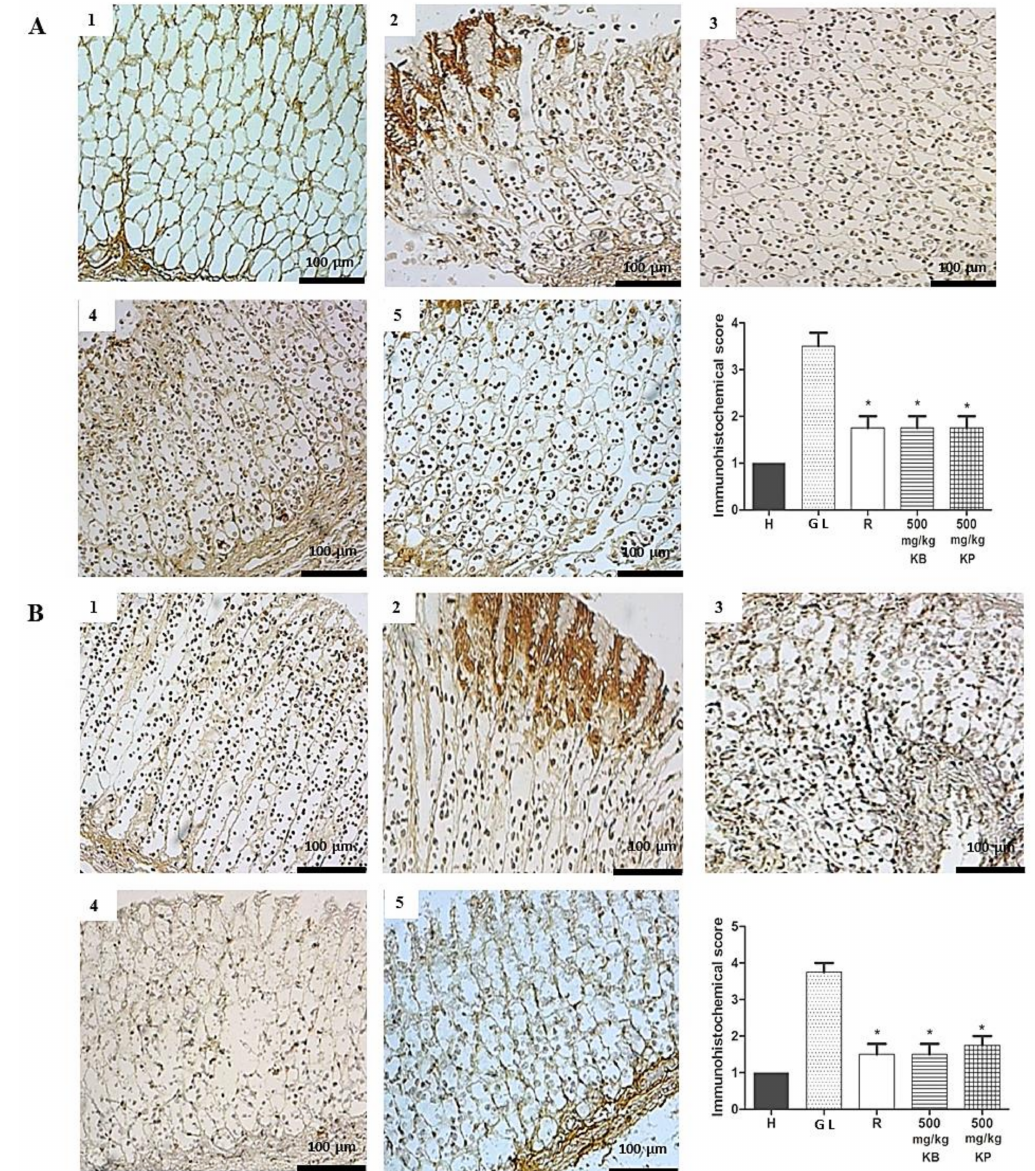
Figure 10. Immunohistochemical analysis of NF- κ B-p65 expression in the gastric mucosa in ethanol-induced and indomethacin-induced gastric lesions in rats. Immunohistochemical analysis of NF- κ B-p65 expression in rat gastric tissue, showing the cut of the stomach in the longitudinal direction. ( A ) Ethanol-induced: (1) Healthy; (2) Gastric lesion control; (3) Ranitidine 50 mg/kg; (4) K. brasiliensis 500 mg/kg; (5) K. pinnata 500 mg/kg. ( B ) Indomethacin-induced: (1) Healthy; (2) Gastric lesion control; (3) Ranitidine 50 mg/kg; (4) K. brasiliensis 500 mg/kg; (5) K. pinnata 500 mg/kg. Data expressed as mean ± standard mean error, ( n = 5). Mann–Whitney used to calculate statistical significance, * p < 0.05. vs. gastric lesion control. Healthy, H; Gastric lesion control, GL; Ranitidine, R. K. brasiliensis , KB; K. pinnata , KP. Immunohistochemical analysis for ZO-1 revealed a strong brown color in epithelial cells such